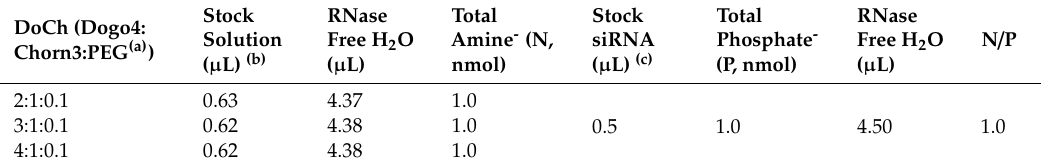
Table 1. Calculation of volume ( µ L) of each DoCh stock solution used to form N / P